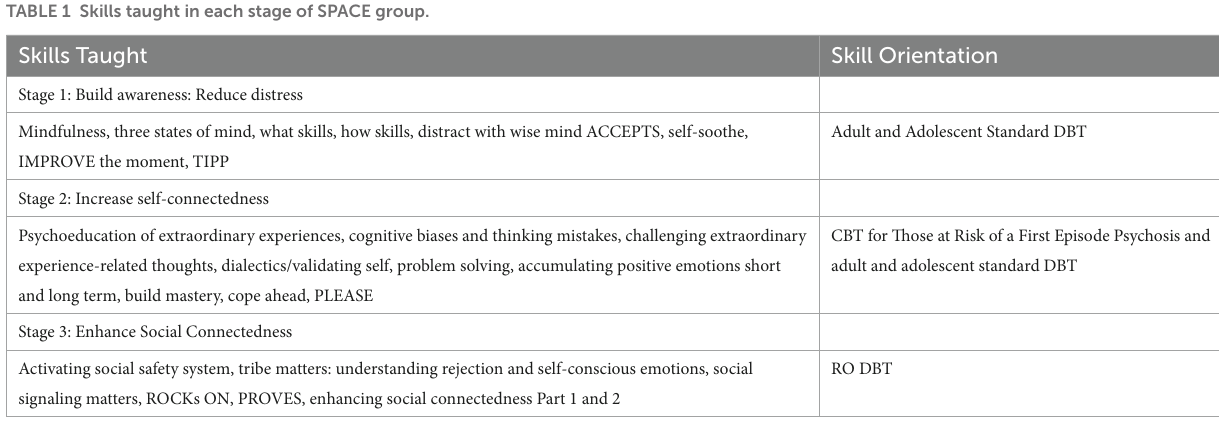
TABLE 1 Skills taught in each stage of SPACE